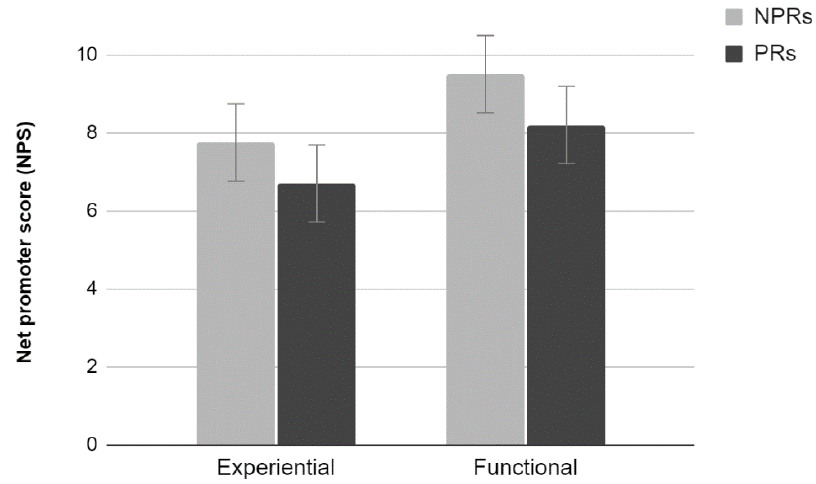
Figure 6. NPS scale score by Experience (NPRs vs. PRs) and Test (Experiential vs. Functional). Error bars denote 0.95 confidence intervals.